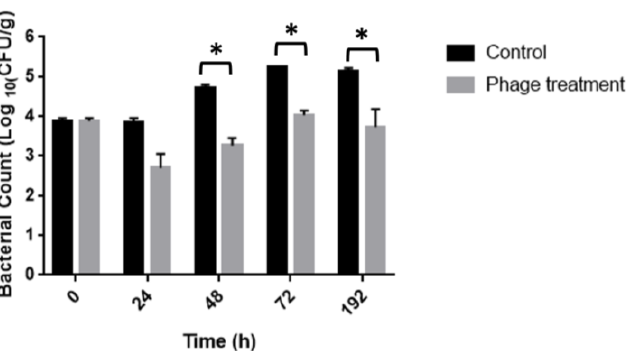
Figure 5. Evaluation of the antibacterial activity of phages cocktail in chicken meat to 10 °C. * p < 0.0001.